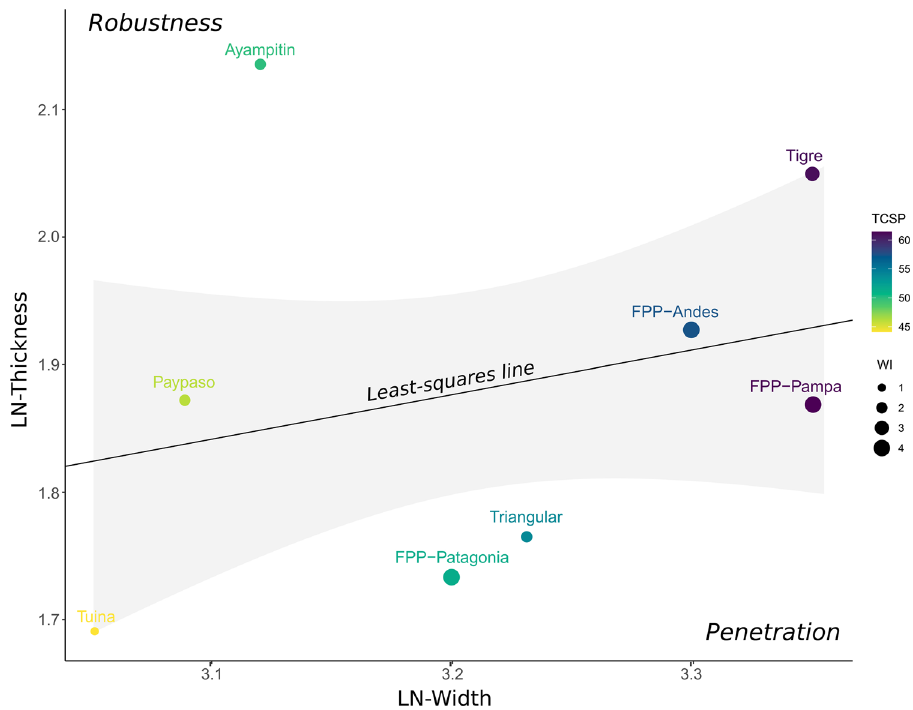
Figure 3. Scatter-plot of the relationship between thickness and width on a logarithmic scale of the six projectile point types separately. The solid line is the least-squares regression line of the data points representing the mean values for each projectile point type. The gray area represents the confidence interval of the least- squares line. Projectile points with means in the upper left above the regression line display designs that maximize robustness, and points in the lower right below the regression line display designs that maximize penetration. The tip cross-sectional perimeter (TCSP) and work investment (WI) are also displayed in color gradient (values expressed in millimeters) and ball size, respectively. See Buchanan and Hamilton 32 for a similar approach to explore effectiveness and damage capability.